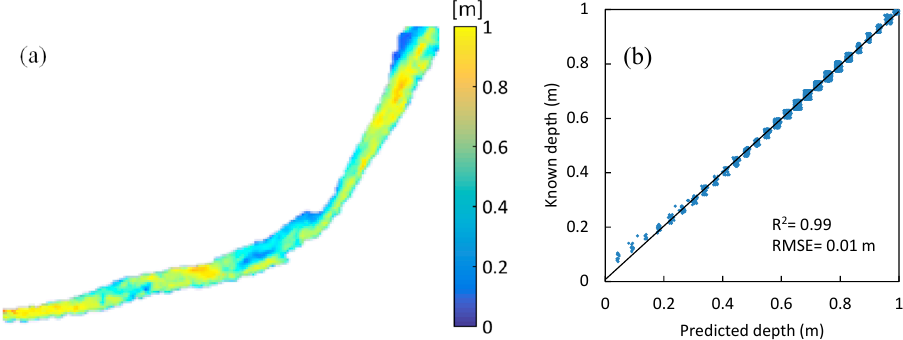
Figure 6. (a) The bathymetry map retrieved for the simulated channel using 𝑅 (cid:3045)(cid:3046)(cid:3020)(cid:3036)(cid:3040)_(cid:3004)(cid:3035)(cid:3028)(cid:3041)(cid:3041)(cid:3032)(cid:3039),(cid:3024)(cid:3023)(cid:2871) and (b) Figure 6. ( a ) The bathymetry map retrieved for the simulated channel using R Sim _ Channel , WV 3 rs and match-up validation. ( b ) match-up